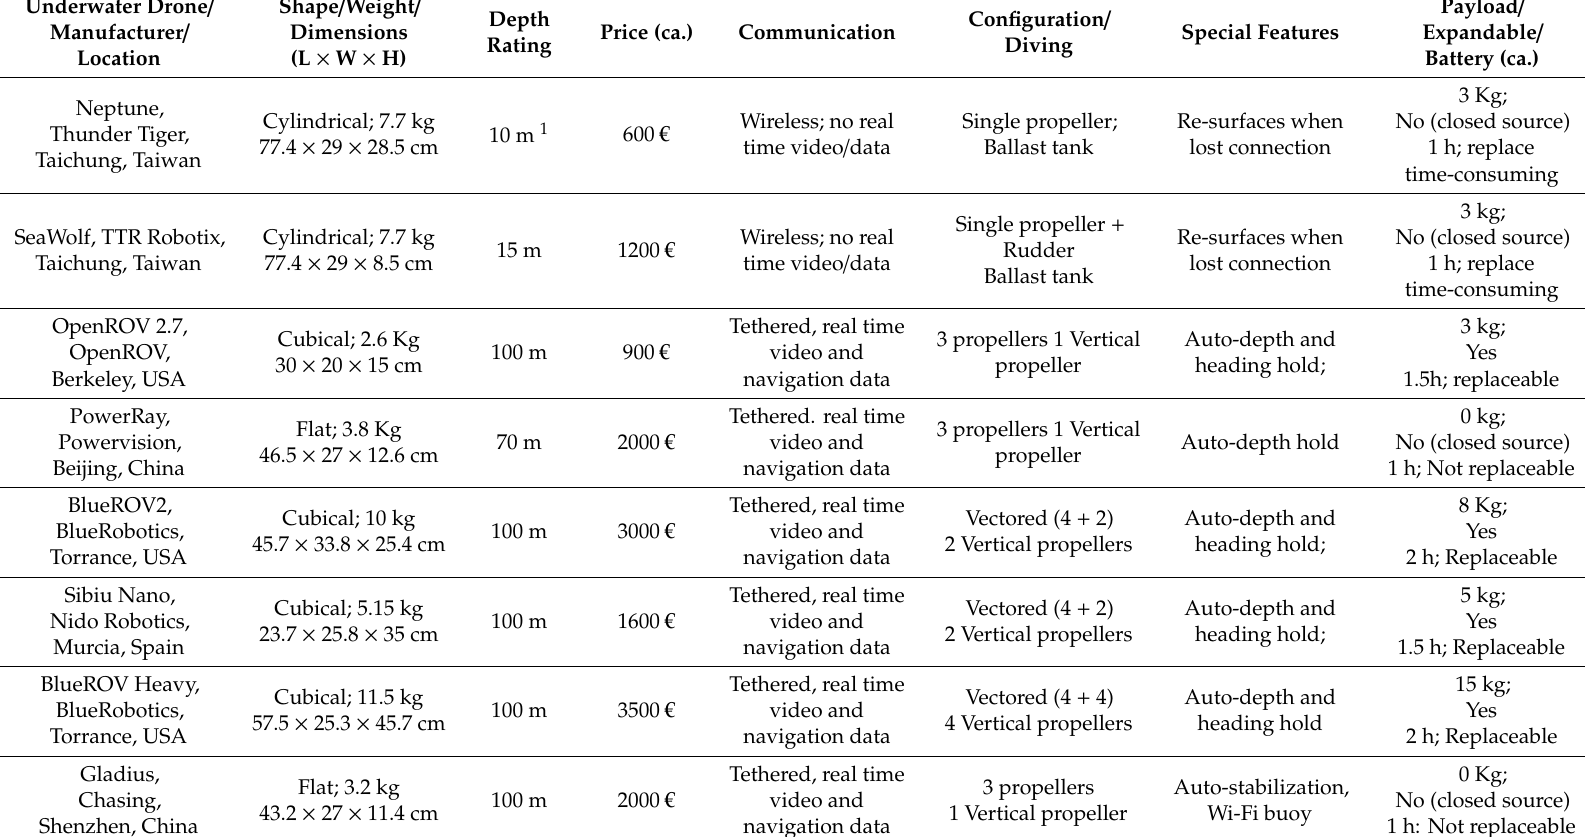
Table 1. Overview of the di ff erent ROVs that were used in this research, with information about their main characteristics and specifications. Underwater Drone /